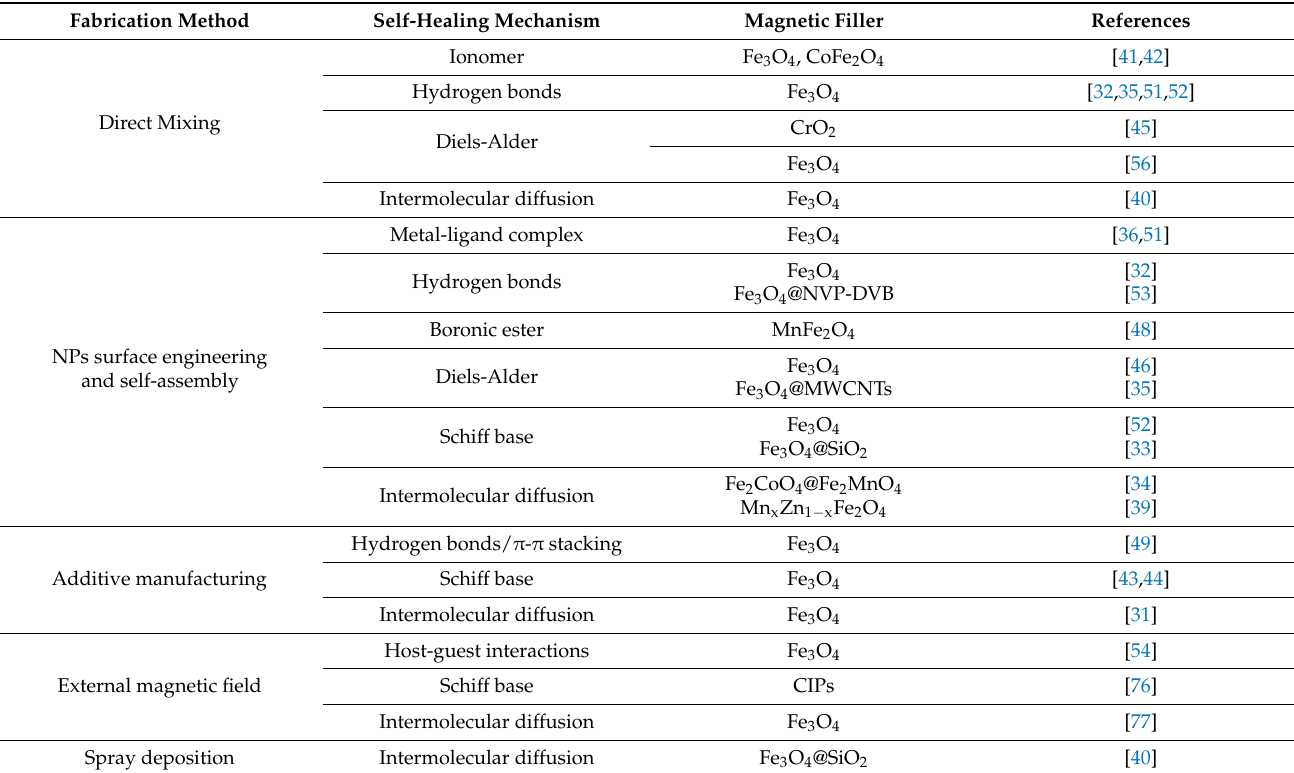
Table 2. The different self-healing mechanisms and magnetic fillers reported for the reported magnetic self-healing composite fabrication